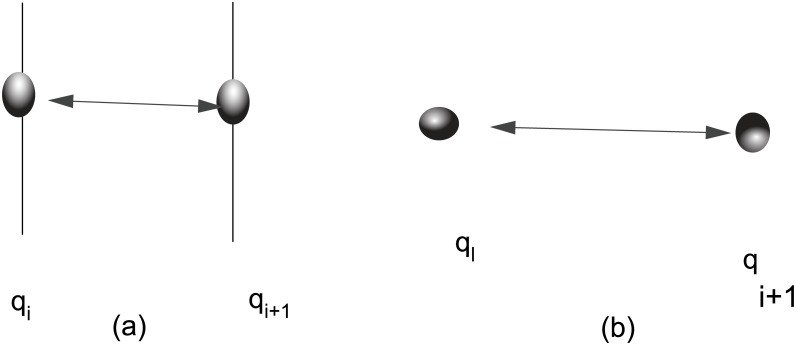
Schematic (a) represents adjacent particles that interact by hard sphere elastic collisions where a harmonic potential operates about the equilibrium position with no direct harmonic or other force coupling between these particles except for the hard sphere collisions. Schematic (b) represents a system where the adjacent particles interact continuously and directly though an inter-particle potential function, such as given in Eq (35).